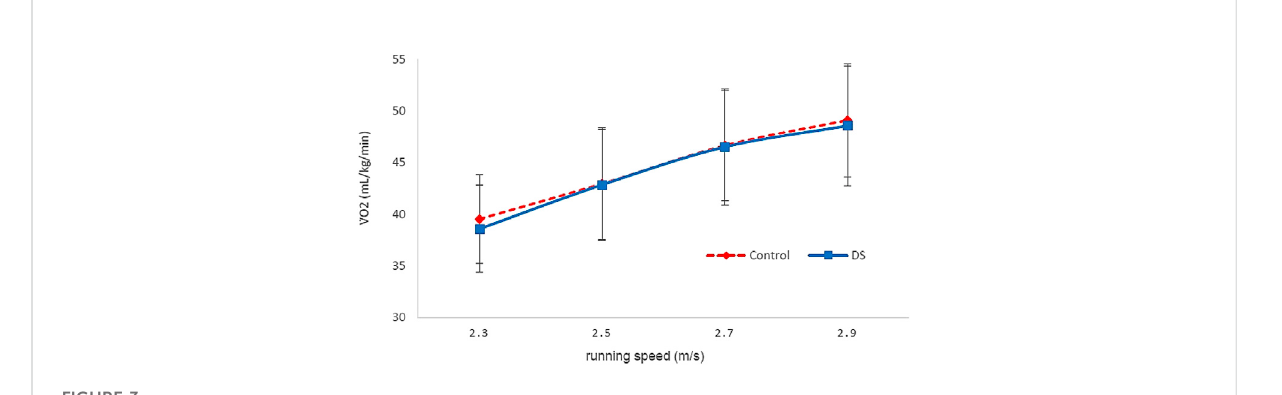
FIGURE 3 V _ O 2 vs. running speed for Dynamic stretching (DS) and Control (C) over the fi rst four stages. Error bars are standard deviations.